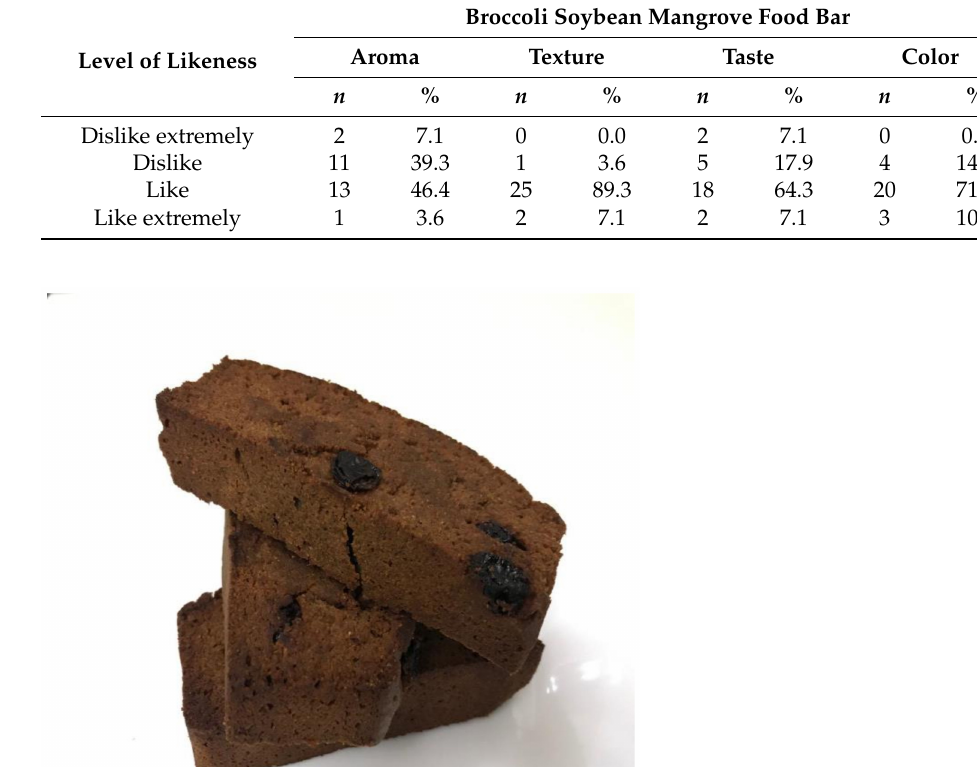
Table 1. Acceptability test.